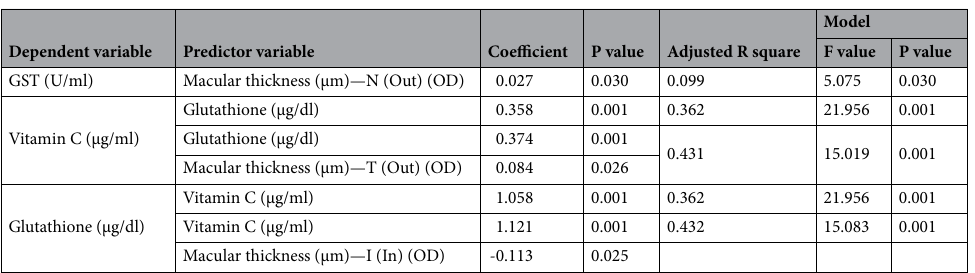
Table 7. Multiple regression using stepwise method for GST (U/ml); vitamin C (μg/ml); glutathione (μg/dl) as a dependent variable.